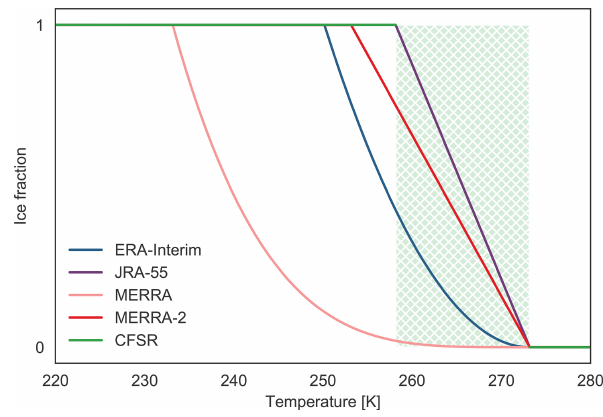
Figure A1. Fraction of new condensate in the ice phase as a function of temperature for ERA-Interim (blue), JRA-55 (purple), MERRA (light red), MERRA-2 (dark red), and CFSR (green). The green shaded region with hatching marks the range of temperatures for which new condensate in CFSR is assigned to the ice phase if ice already exists at or above the grid cell in question and is assigned to the liquid phase